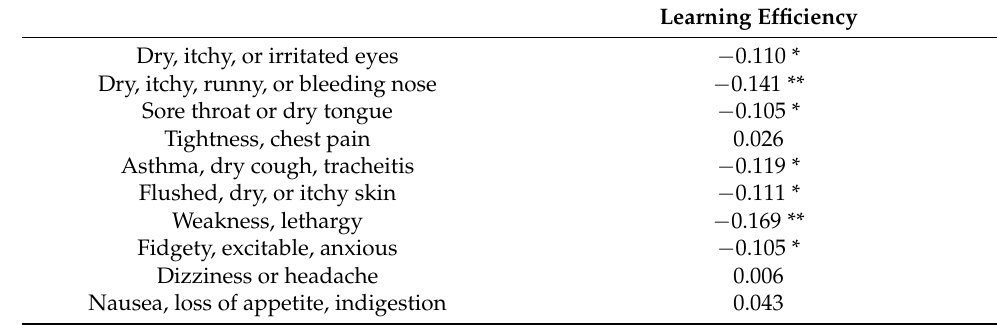
Table 10. Relationship between the occurrence of SBS symptoms and learning